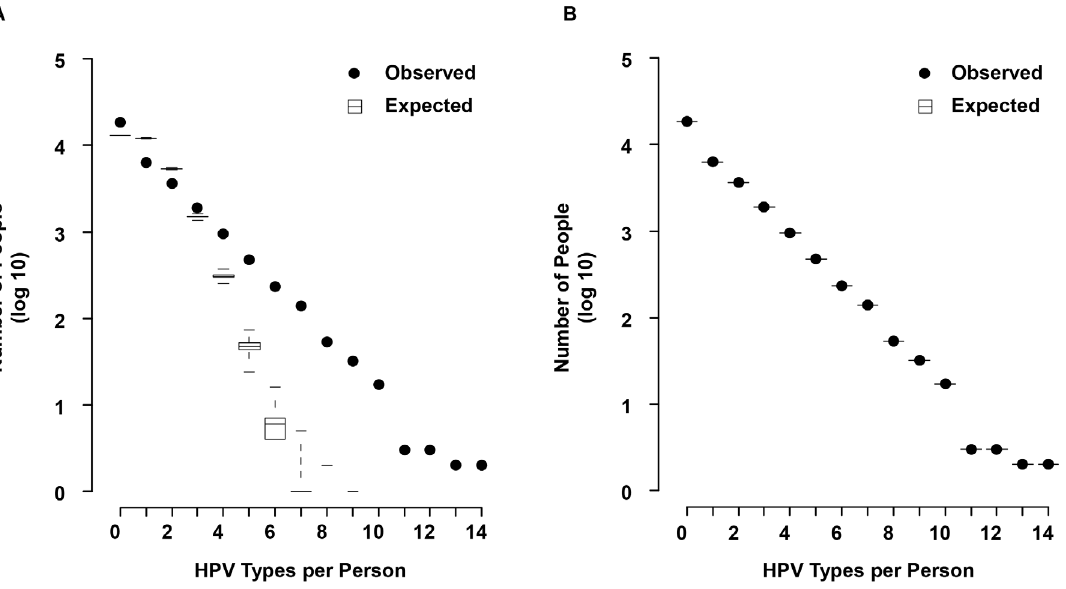
Figure 2. Differences between observed and expected number of people with concurrent infections. Dots representing observed number of concurrent infections are plotted against boxplots of expected distribution from 10,000 randomized matrices. Boxplots indicate the minimums and maximums, 25% and 75% quartiles, and medians of randomized matrices. ( A ) tests the null model of complete random association of HPV types as in Figure 1B. ( B ) controls for observed types per person in the non-strata fixed margins permutation model as in Figure 1C. Note that because the margins for all randomized matrices are set to be equal to that of the observed data and thus the same value for each permutation, the ‘‘boxes’’ have no ranges and are represented as single-value lines.